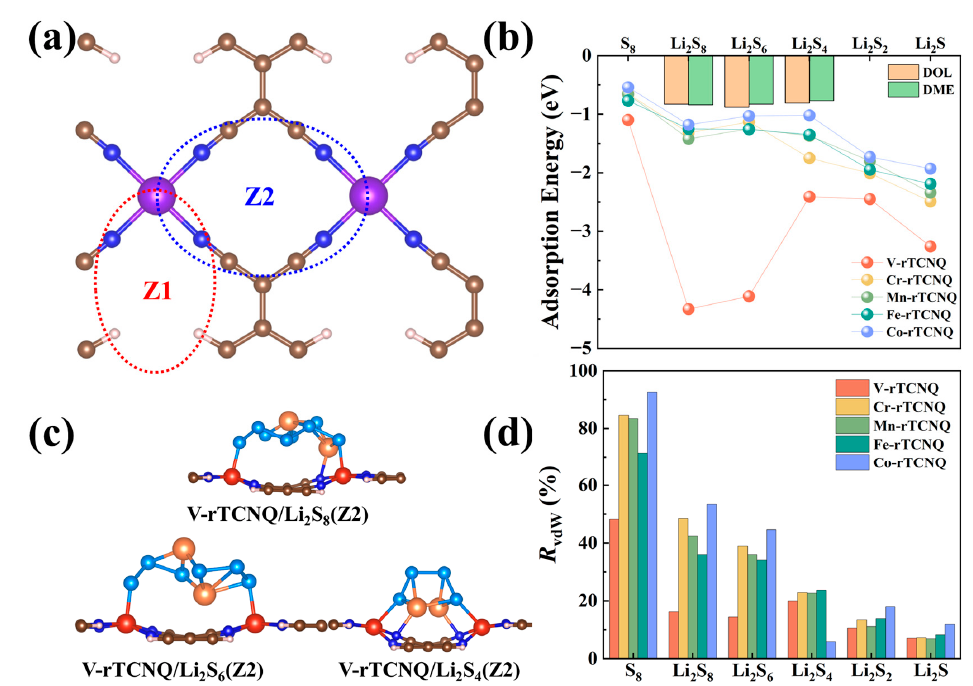
Figure 2. ( a ) Schematic diagram of Z1 and Z2 adsorption patterns. ( b ) The adsorption energies of TM-rTCNQ (V, Cr, Mn, Fe and Co) structures for S 8 /LiPSs. ( c ) The top and side views of V-rTCNQ adsorbing Li 2 S 4 , Li 2 S 6 and Li 2 S 8 in Z2 pattern. ( d ) The ratio of van der Waals ( R vdW ) interaction of TM-rTCNQ (V, Cr, Mn, Fe and Co) adsorbing S 8 /LiPSs clusters.